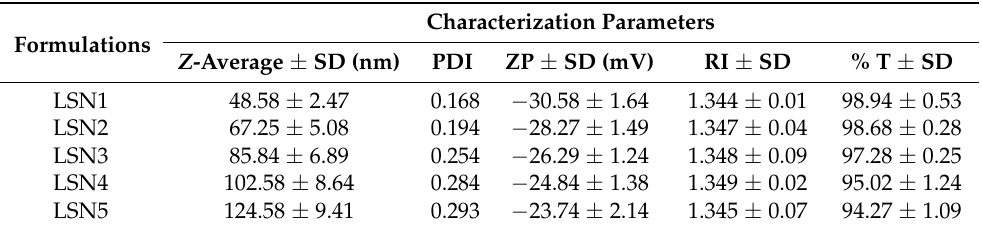
Table 4. Physicochemical parameters for various LUT-SNEDDS (mean ± SD, n = 3). Characterization Formulations